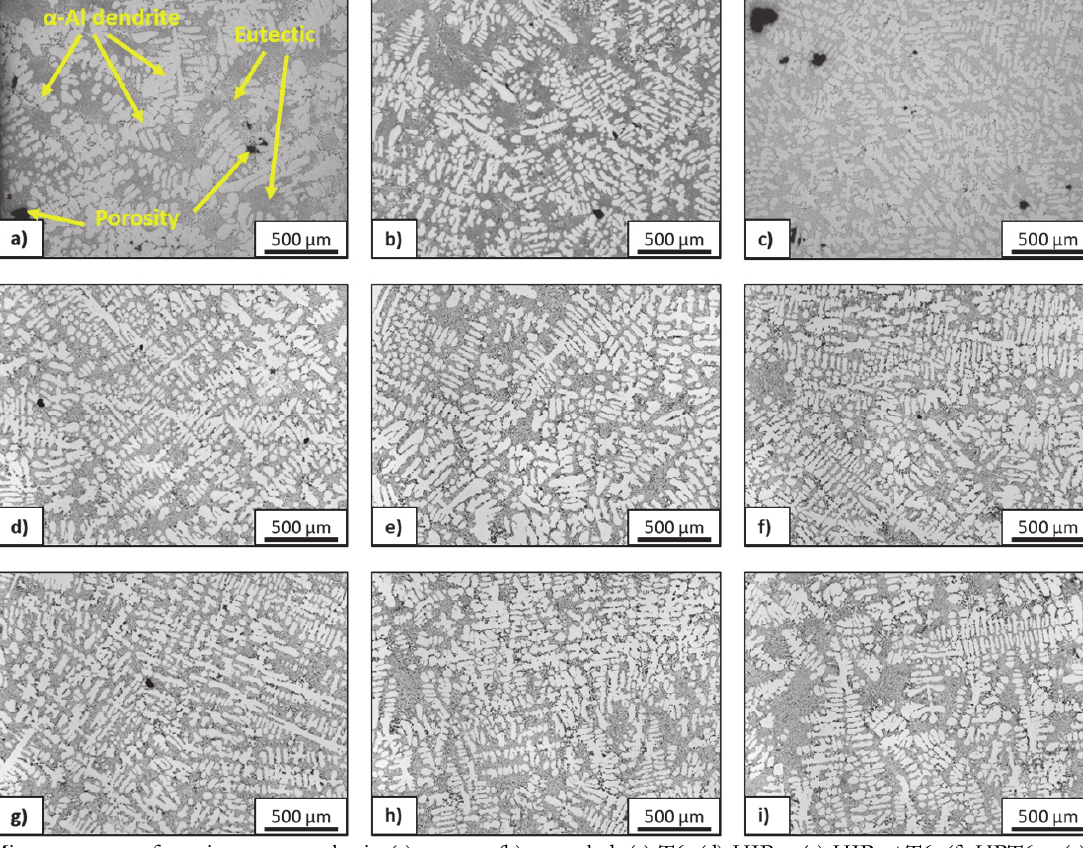
Figure 2: Microstructure of gravity cast samples in (a) as-cast, (b) annealed, (c) T6, (d) HIP 50 , (e) HIP 50 +T6, (f) HPT6 50 , (g) HIP 150 , (h) HIP 150 +T6, (i) HPT6 150